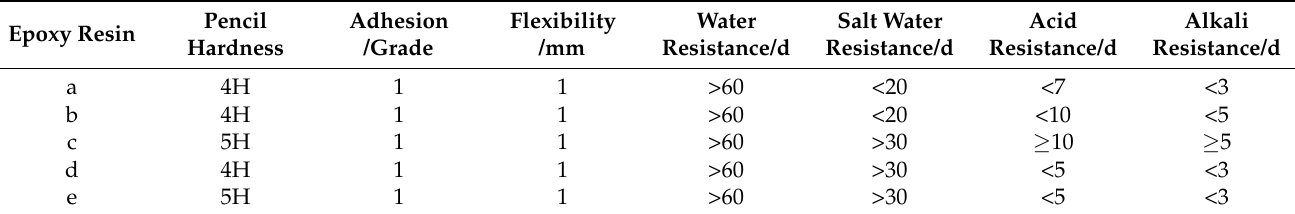
Table 3. Comparison of the performance of different epoxy resin coatings.